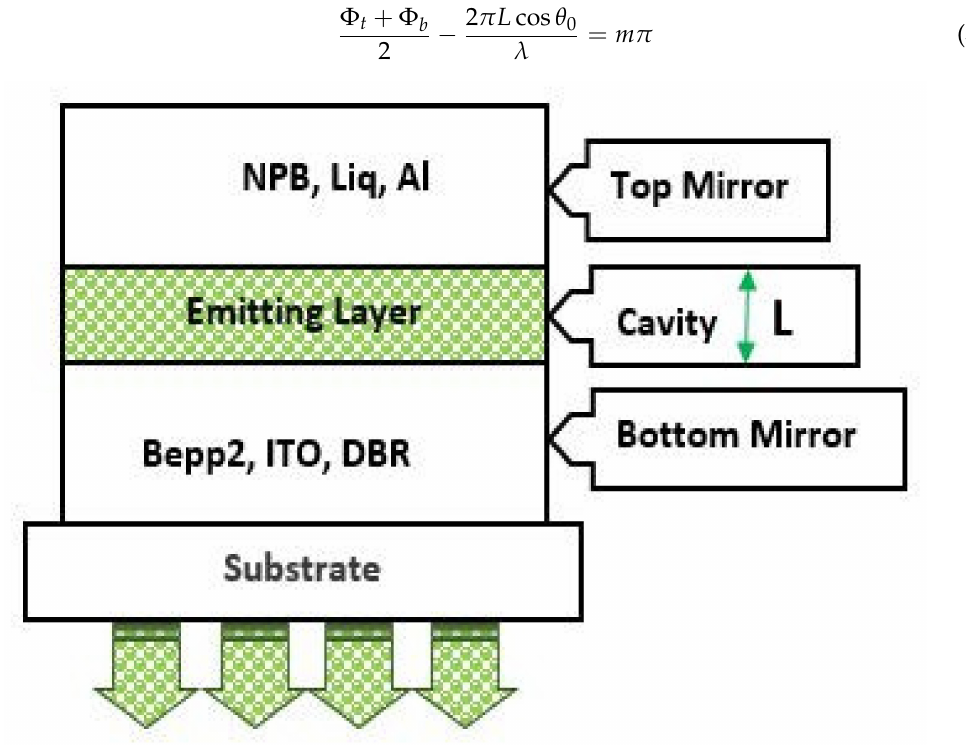
Figure 3. Microcavity structure used for an optical